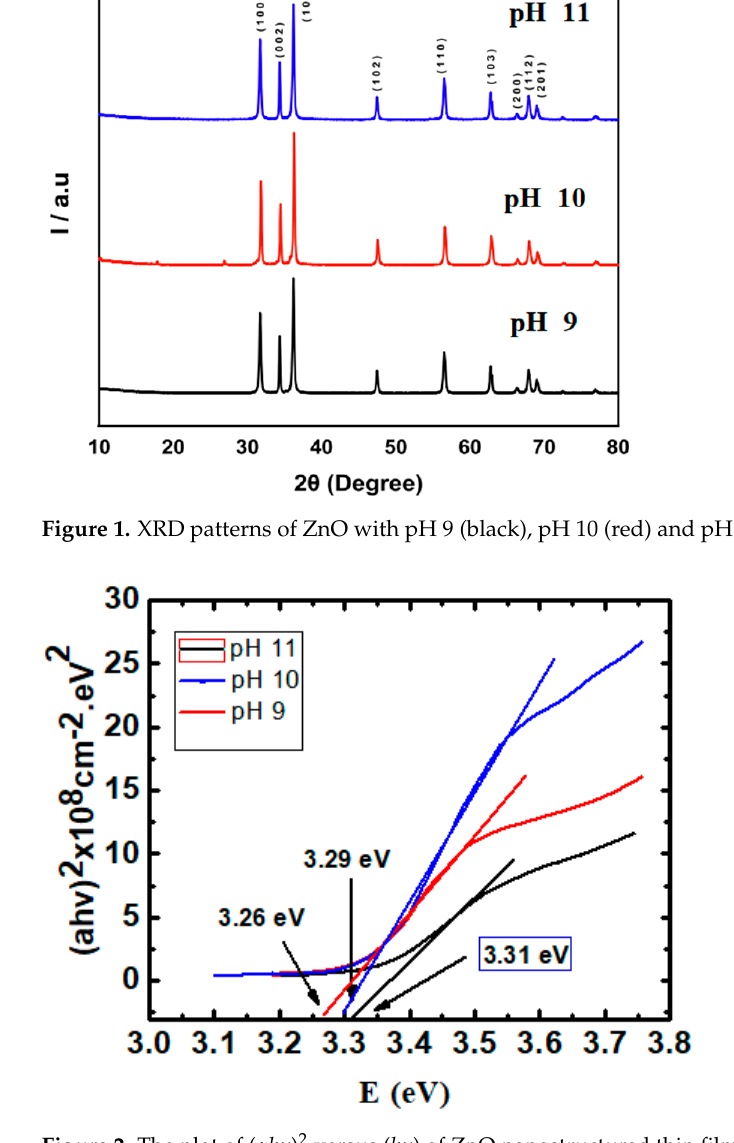
Figure 1. XRD pa tt erns of ZnO with pH 9 (black), pH 10 (red) and pH 11 (blue).